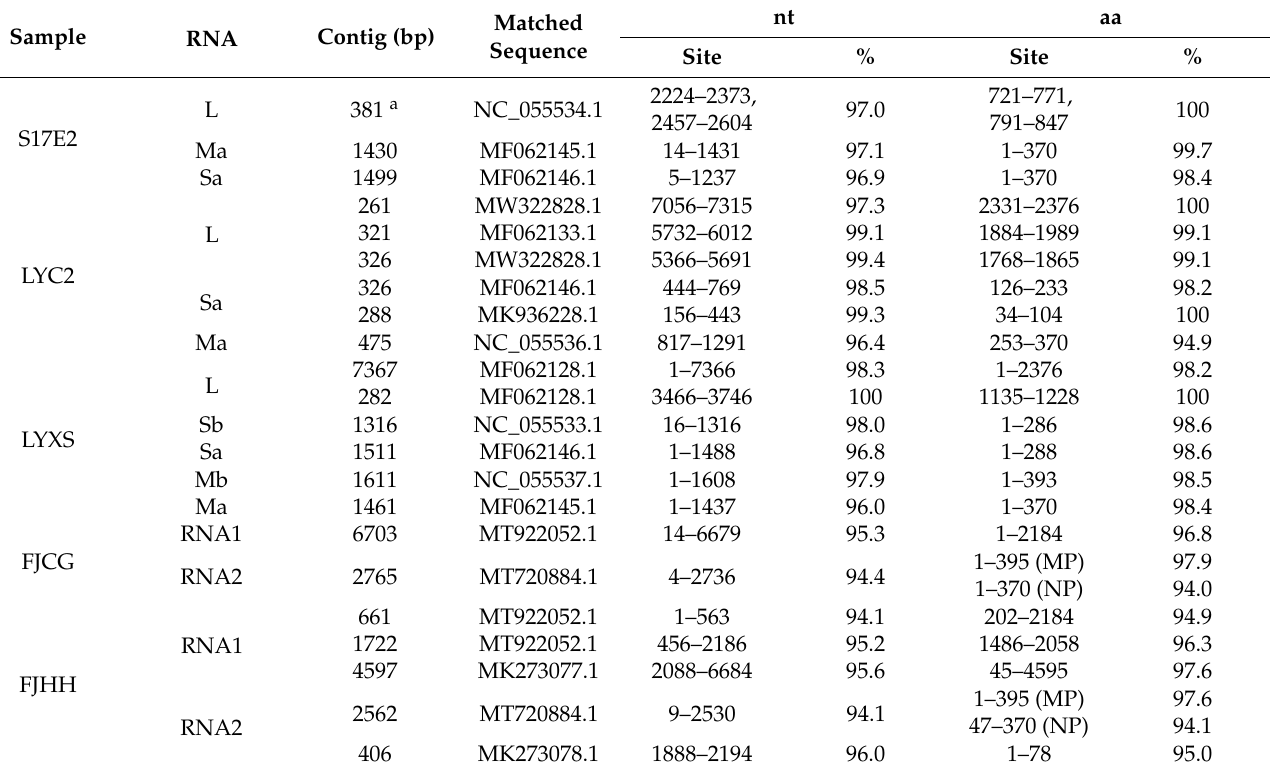
Table 1. Blast analysis of contigs derived by RNA-seq from five pear